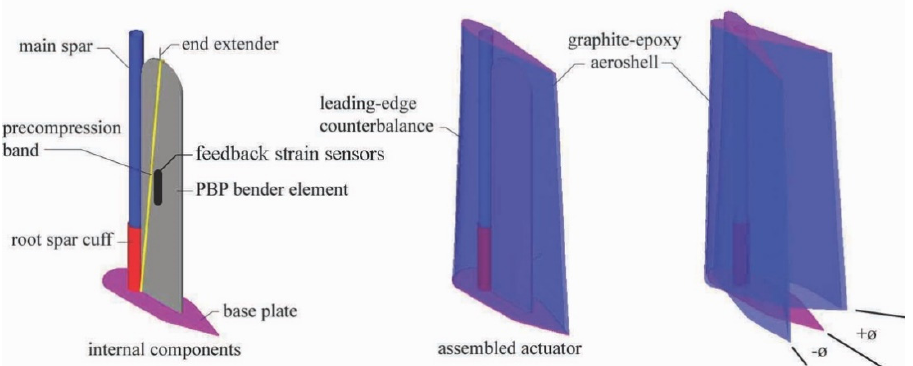
Figure 7. PBP Actuator Configuration within 5 cm × 2.5 cm Aeroshell.